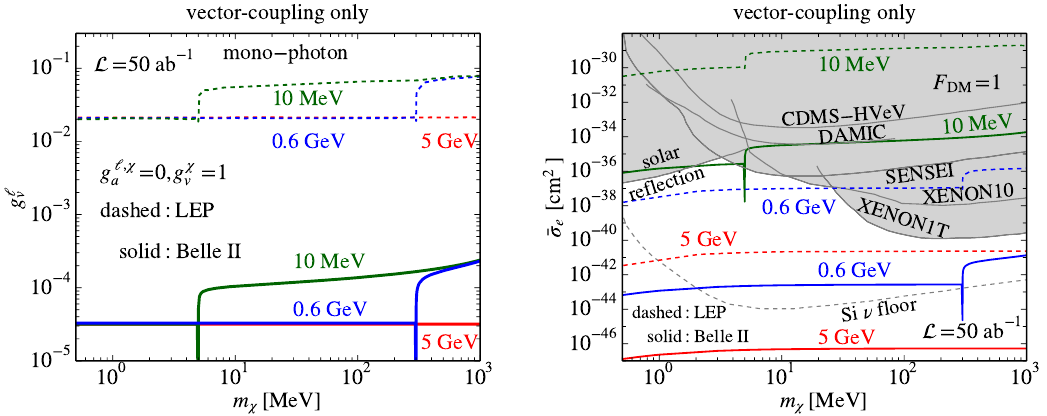
= 5 GeV (red), m = Z 0 Z 0